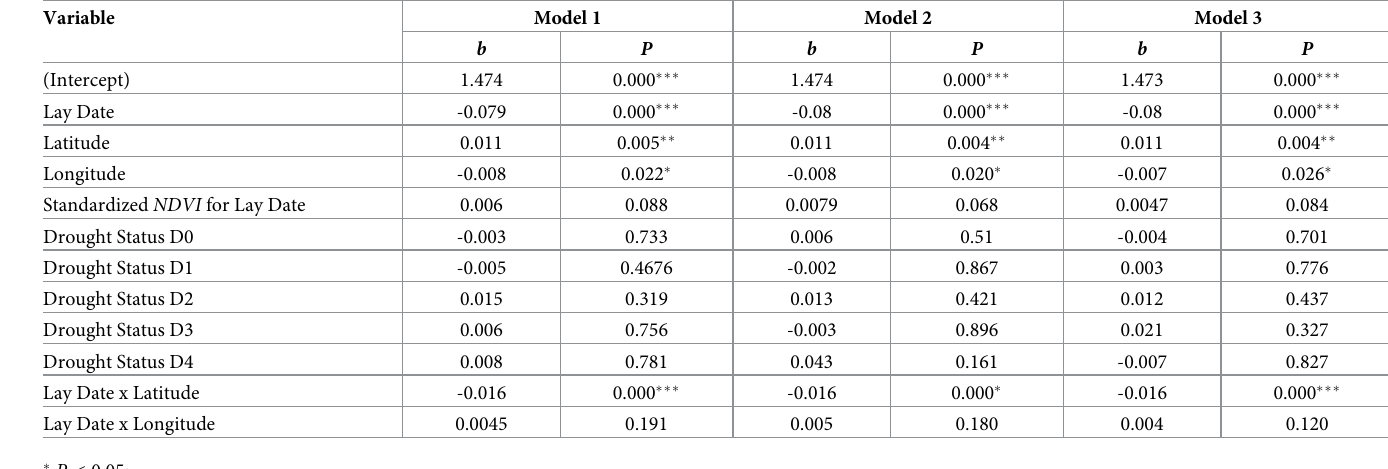
Table 2. Parameter β estimates ( b ) and probabilities ( P ) for three generalized linear models used to evaluate drought effects on Eastern Bluebird clutch size. Explanatory variables for all models are Julian lay date, latitude, longitude, standardized NDVI, and interactions between Julian lay date and latitude, and Julian lay